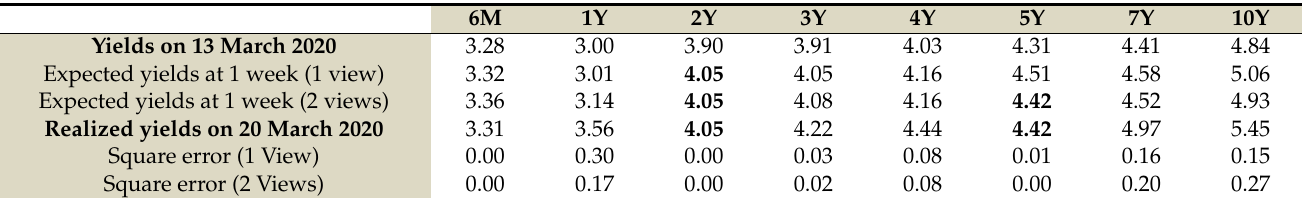
Table 13. Factor loadings , eigenvalues, and variances explained by the first two PCs on 28 February